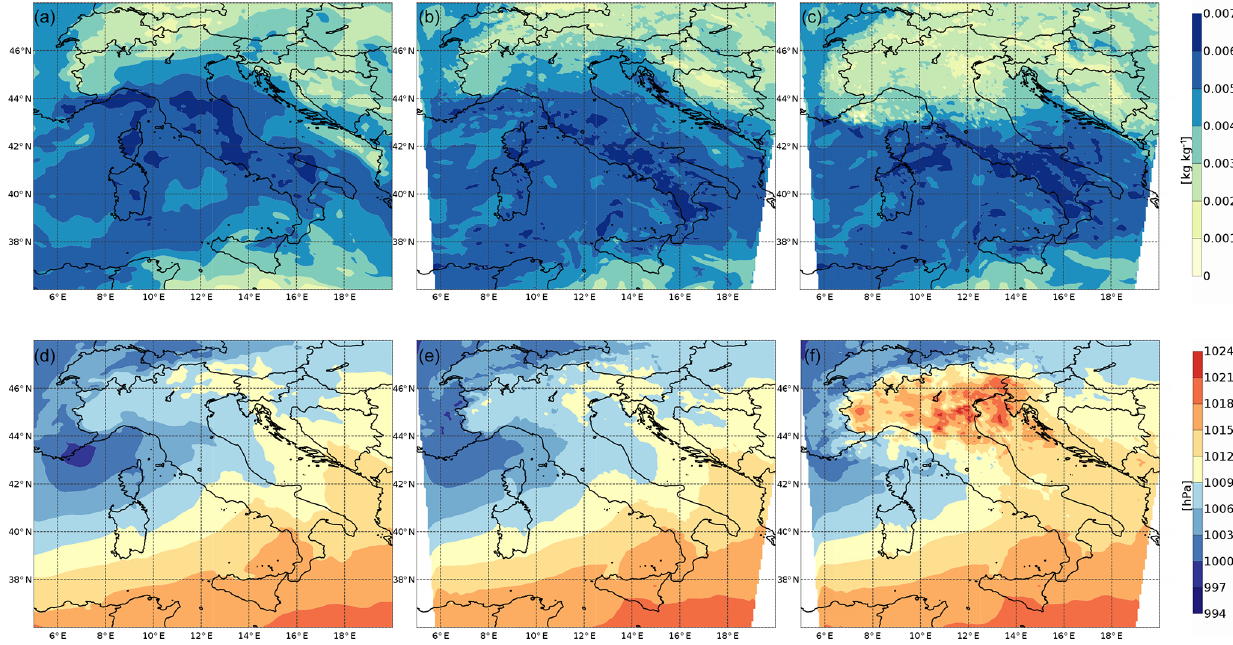
Figure 12. Mean sea level pressure (a–c) and specific humidity at 850hPa (d–f) analysis on 5 February at 12:00UTC for IFS (a, d) rad60 (b, e) and rad15_roe0.5 (c, f)